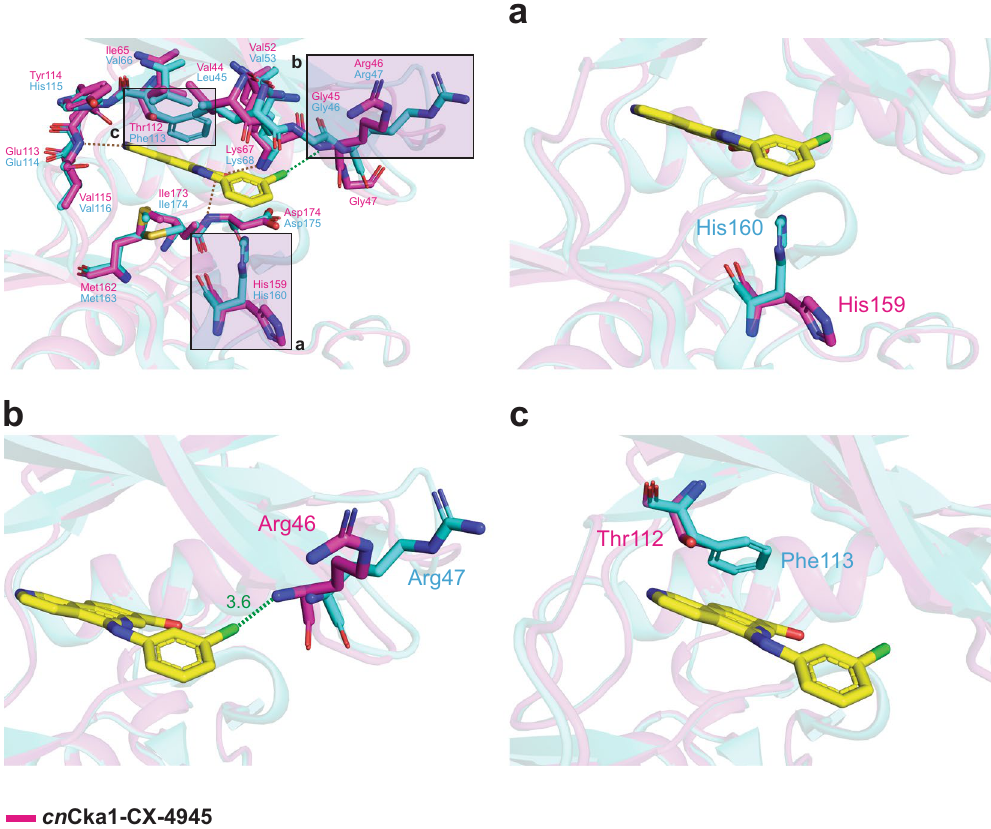
Figure 7. Deviations in protein-inhibitor interactions when CX-4945 is bound. The cn Cka1-CX-4945 structure is shown in magenta and the hs CK2 α -CX-4945 (PDB code: 3PE1 ) structure is shown in cyan. CX-4945 is shown in yellow. Hydrogen bonds are depicted as brown dashed lines and electrostatic interactions are depicted as green dashed lines. Superimposition of the cn Cka1-CX-4945 and hs CK2 α -CX-4945 structures showing the residues around the catalytic cleft. ( a ) Interaction of His159 (His160 in hs CK2 α ), ( b ) Arg46 (Arg47 in hs CK2 α ) and ( c ) Thr112 (Phe113 in hs CK2 α ) with